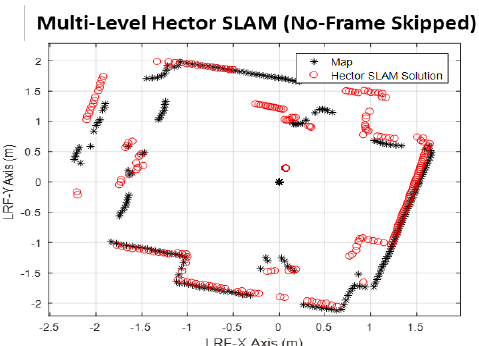
Figure 11. Hector SLAM performance during second experiment with no frame skipped during harsh maneuver